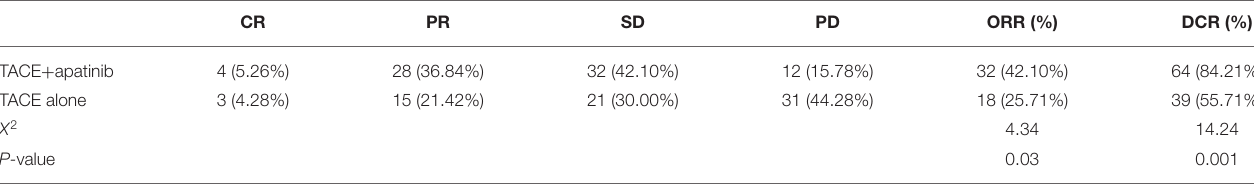
TABLE 2 | Tumor remission in two groups [n (%)].